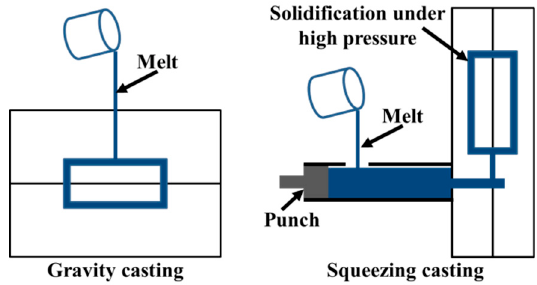
Figure 1. Schematic diagram of gravity casting and squeezing casting.